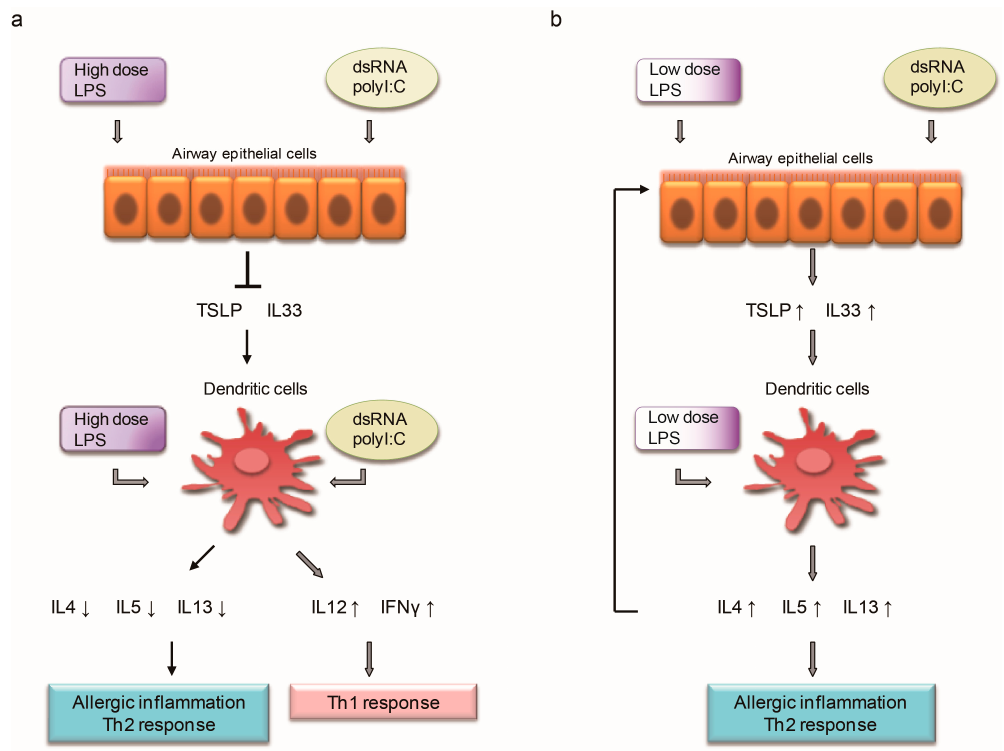
Figure 1. ( a ) Before sensitization, when the LPS level in the environment is high, each episode of common cold infection (dsRNA) cause no effect on epithelial cells (ECs), but stimulate dendritic cells (DCs) to skew towards Th1 prone except RSV infection, which is Th2 prone. ( b ) When the LPS level in the environment is low, each episode of common cold infection (dsRNA) then stimulate the epithelial cells to produce proallergic cytokines, such as thymic stromal lymphopoietin (TSLP) and IL33, which would facilitate T cells to produce more IL4, IL5 and IL13, and these Th2 cytokines would work synergistically with dsRNA to stimulate ECs to produce more IL33 and TSLP, forming a positive feedback cycle, and thus shaping the allergic predisposition seen clinically.